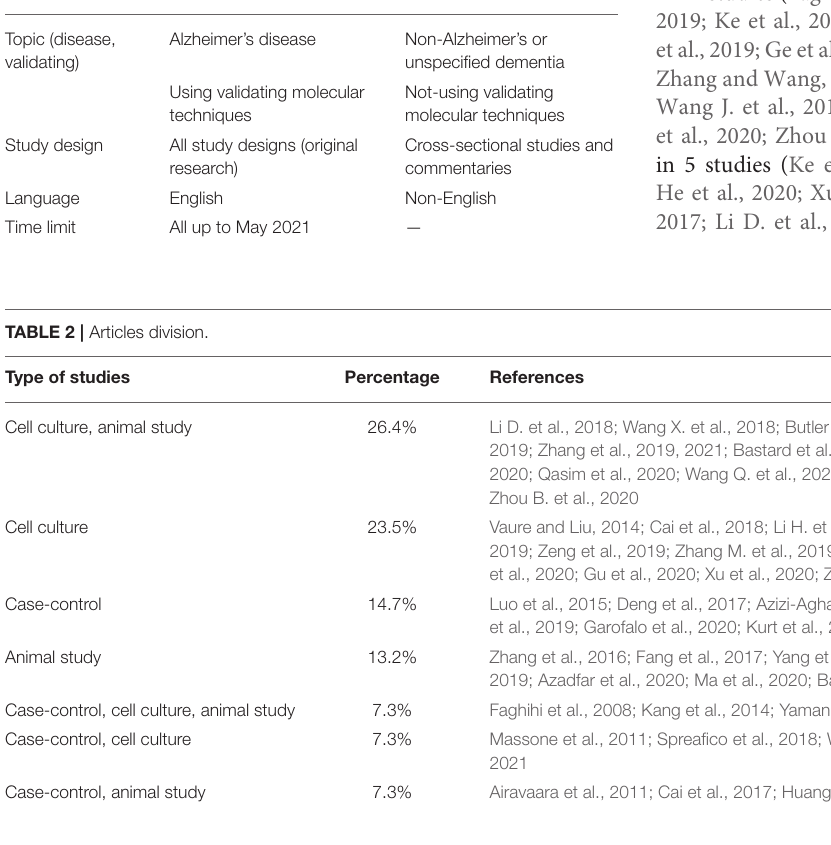
Table 1 . The article’s full text was reviewed, and irrelevant articles were deleted, and the articles remained utterly consistent with